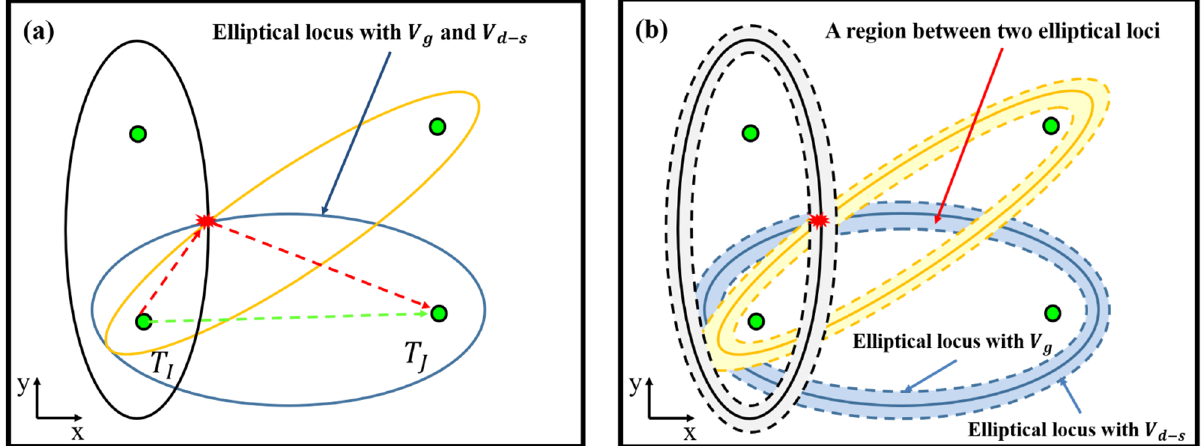
Figure 1. Schematic view of ToF-based ( a ) ellipse method and ( b ) modified ellipse method in a sensor network.